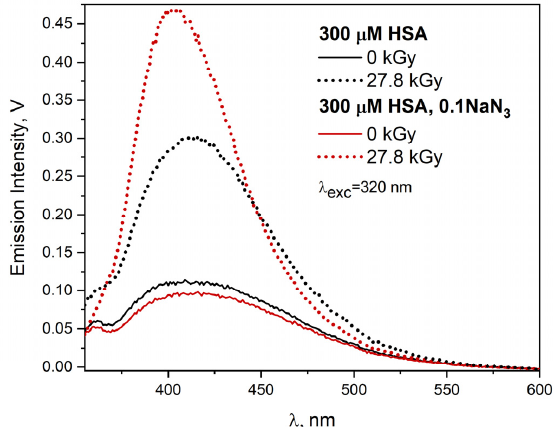
Figure 20. Emission spectrum of neat HSA solution (300 µM) and HSA solution containing NaN 3 (0.1 M). Emission spectra of N 2 O-saturated buffer solution of HSA (300 µM) and containing NaN 3 (0.1 M), obtained for irradiation dose 27.8 kGy. The excitation wavelength was 320 nm. The reaction of the • OH radical with HSA leads mainly to species other than DT, as